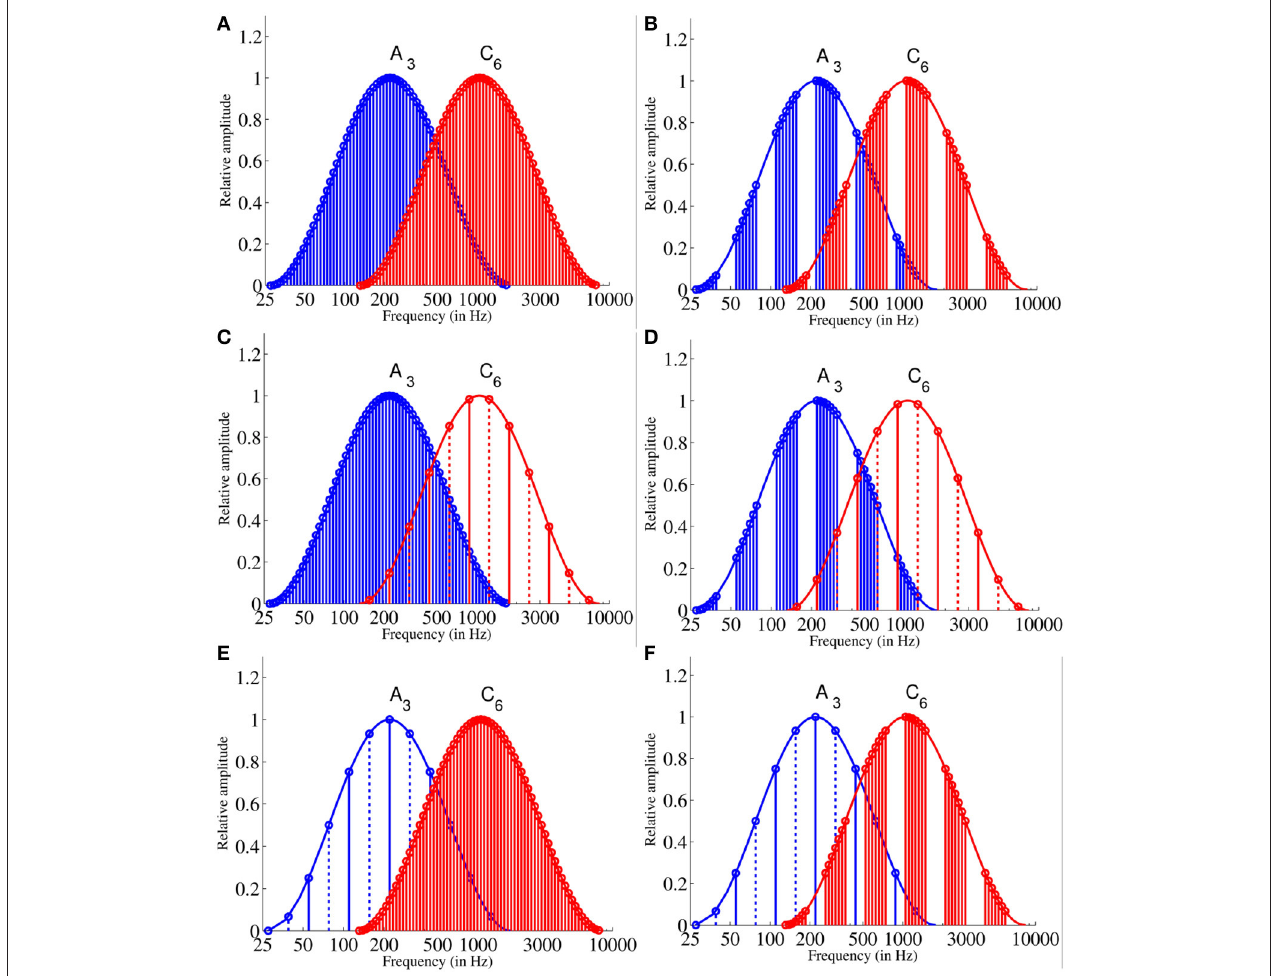
FIGURE 3 | Frequency spectra of adaptor und test stimuli: The 12 Shepard tones of the long adaptor (A) and the 7 Shepard tones of the short adaptor sequences (B) generated under the A 3 envelope and the C 6 envelope. The stimuli of the long (C) and the short (D) adaptor sequence generated under the A 3 envelope in comparison to the tritone pair A − D generated under the C 6 envelope. The stimuli of the long (E) and the short (F) adaptor sequence generated under the C 6 envelope in comparison to the tritone pair A − D generated under the A 3 envelope. The solid lines represent the spectra of the first Shepard tones and the dotted lines that of the second Shepard tone. Each Shepard tone consists of 6 octave components. Note, the first or the 6th component is hard to see due to